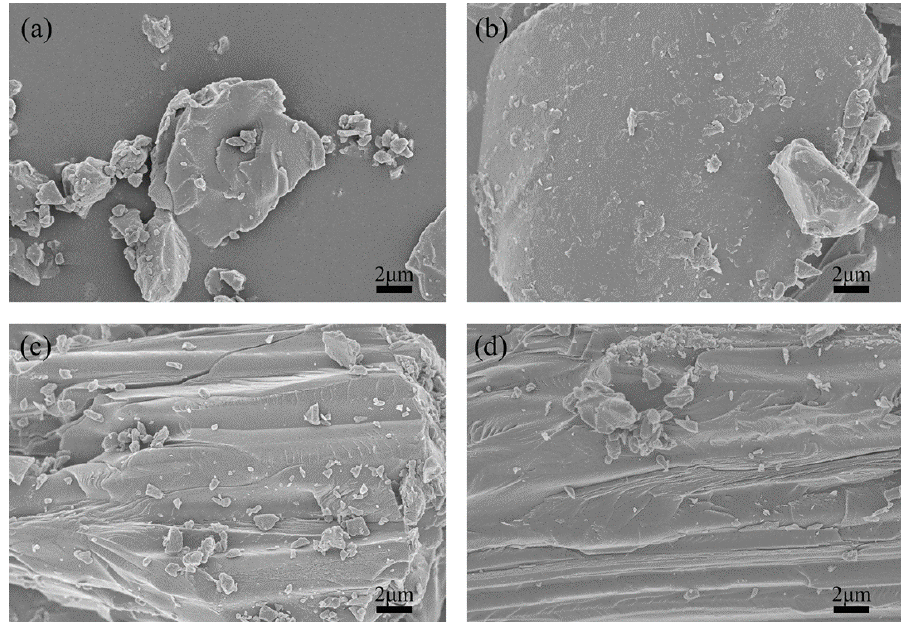
Figure 5. Effect of N-doping time on material’s optimization: ( a ) green petroleum coke, ( b ) N-GLPs 750 2 , ( c ) N-GLPs 750 4 , and ( d ) N-GLPs 750 6 . XRD